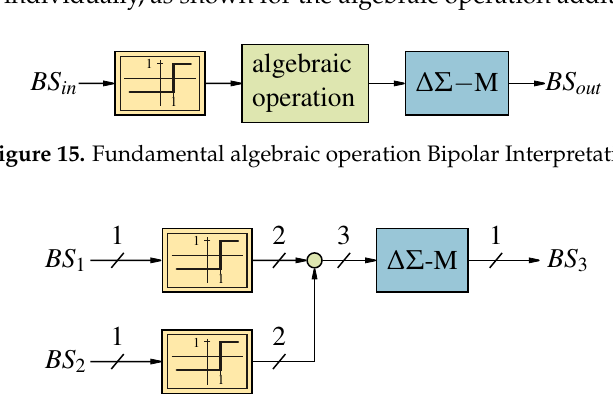
Figure 16. The ∆Σ SP operation addition operated with Bipolar